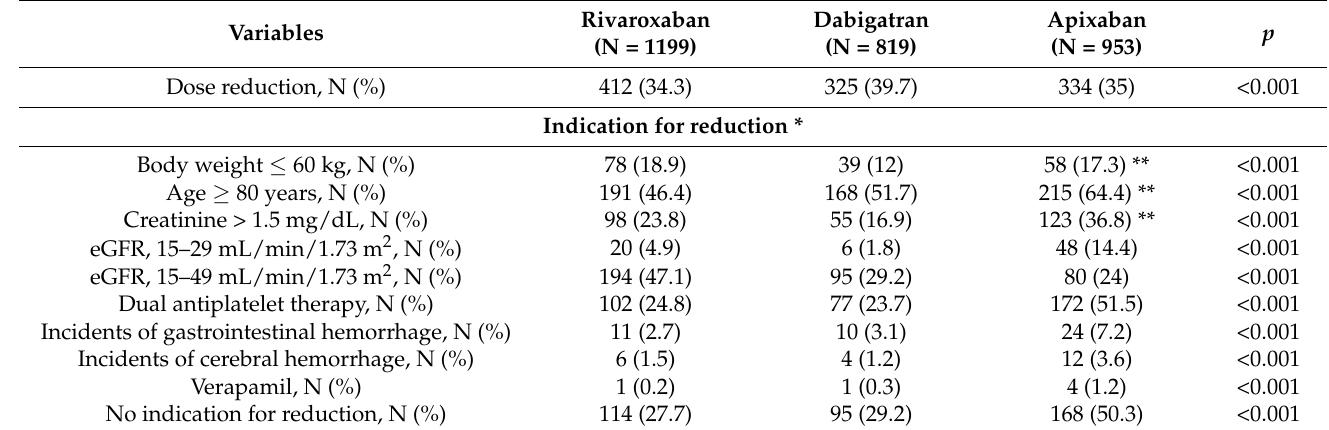
Table 1. Detailed criteria for NOAC dose reduction in the study